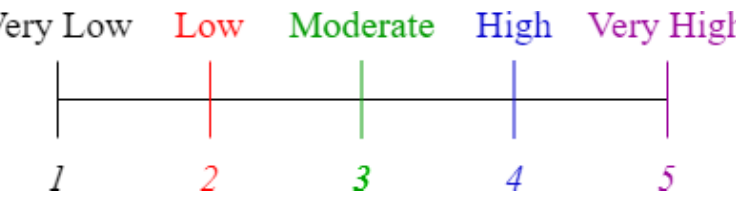
Figure 14. Linguistic scale in FMEA.